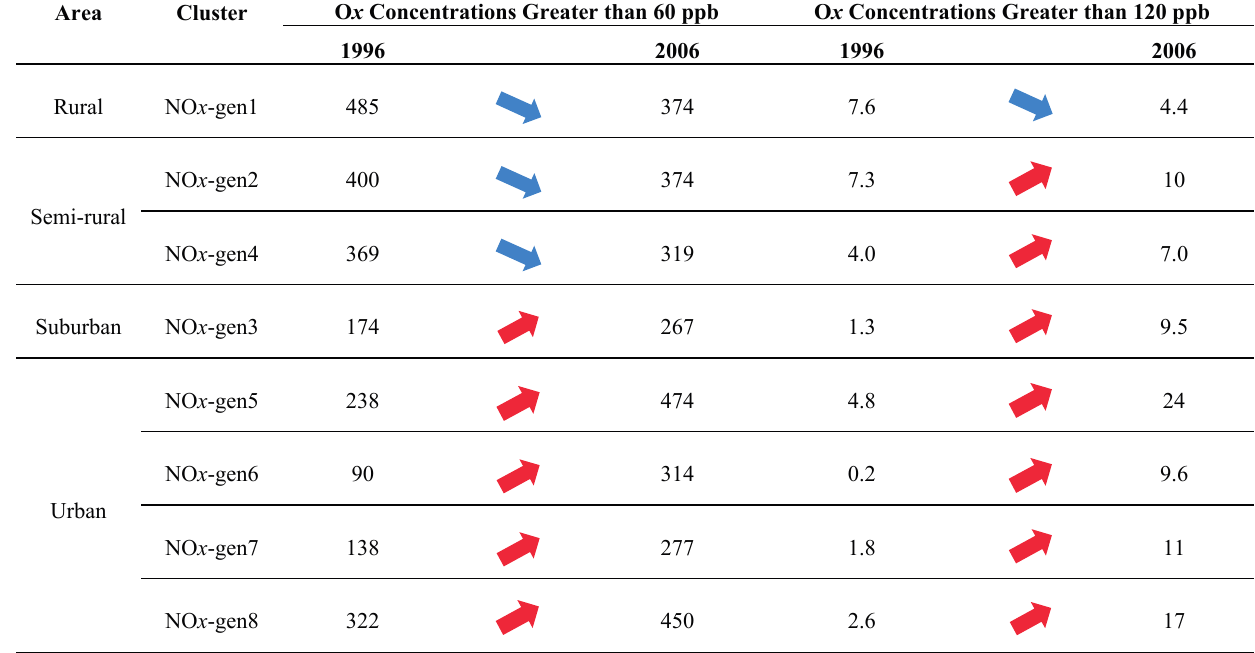
Table 1. Average total number of times in which O x concentrations greater than 60 and 120 ppb were observed in each